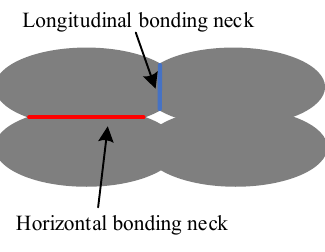
Figure 1. Schematic diagram of bonding neck. Table 1. Four different types of surface roughness.